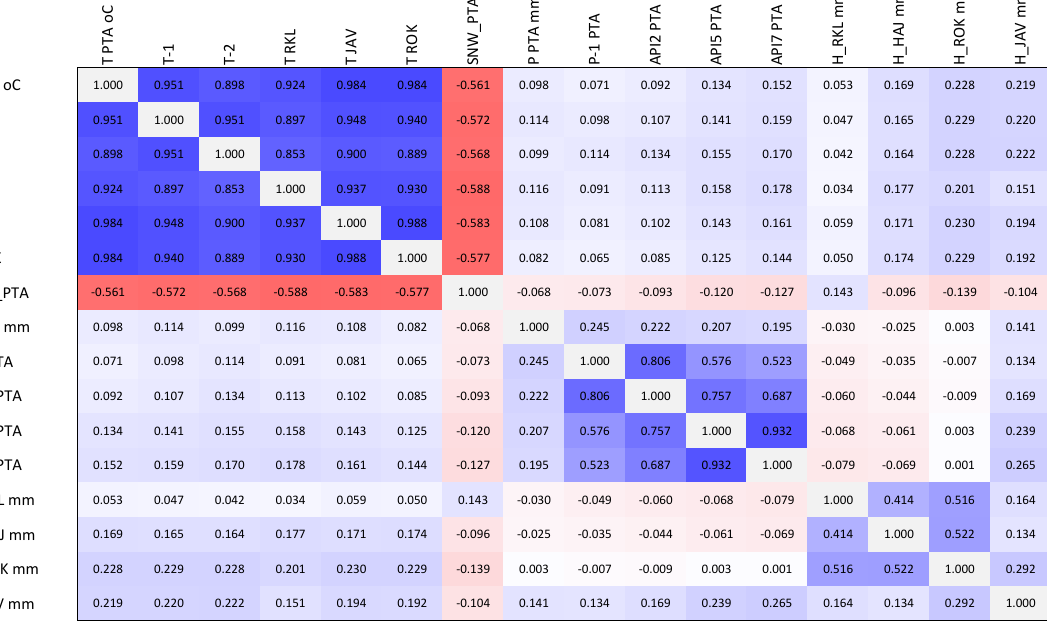
Figure 5. Cross-correlation of